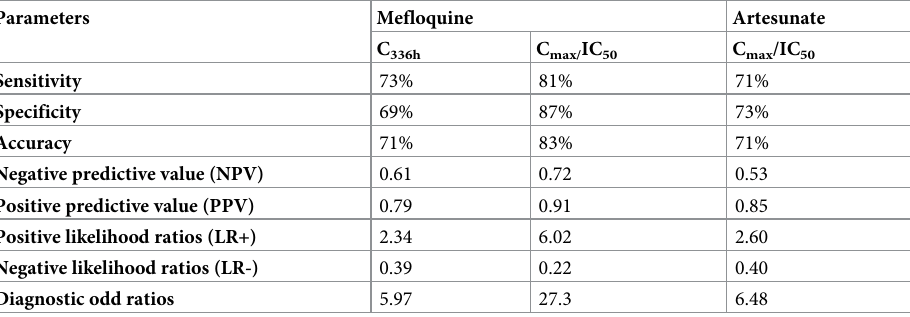
Table 3. Model parameters for internal validation.